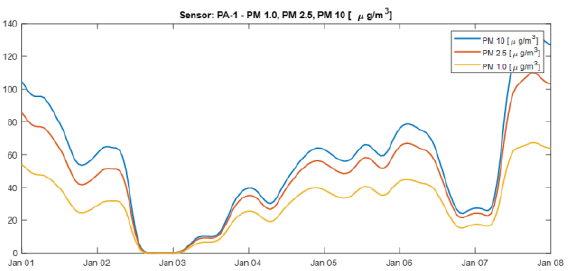
Figure 4. Joint graphics of PM 1.0, PM 2.5 and PM 10 for sensor PA-1 and one week